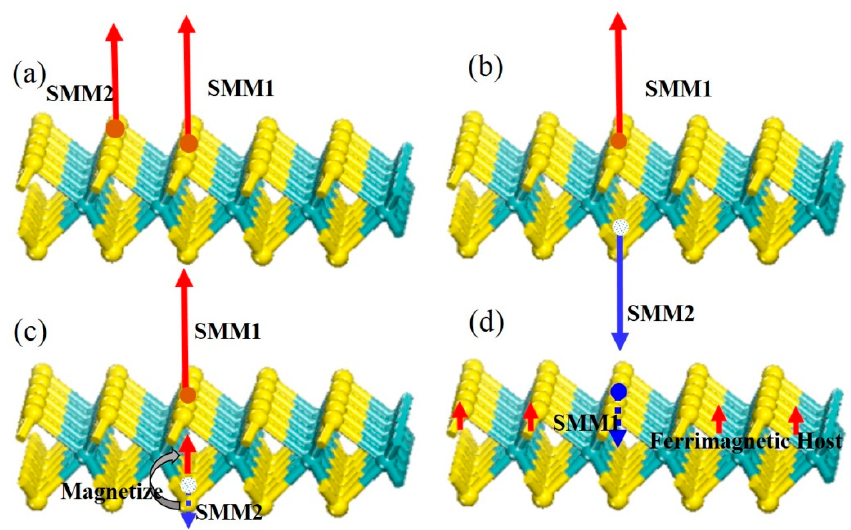
Figure 6. Single molecular magnet (SMM) interaction schemes. ( a ) Two ferromagnetic SMMs are placed on the same side of the MoS 2 host; and ( b ) placed exactly mirror symmetric to each other; ( c ) one ferrimagnetic SMM is magnetized by the top ferromagnetic SMM; and ( d ) denotes the antiferromagnetic interactions between a ferrimagnetic SMM and a ferrimagnetic substrate.